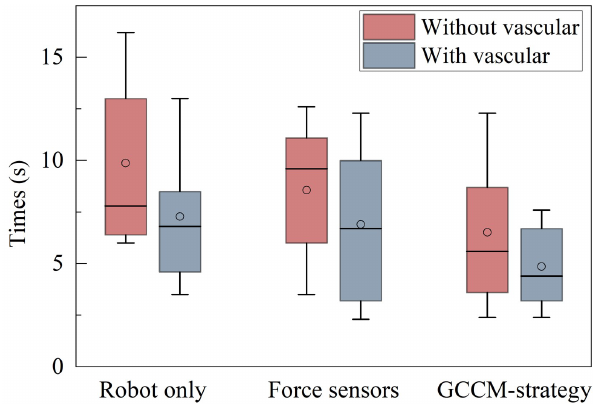
Figure 13. Rotation time from five operators.